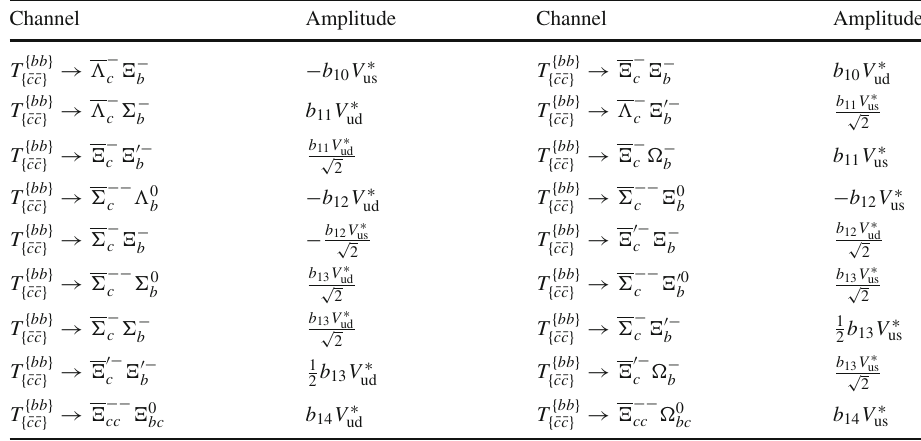
¯ c quark decay. The lowest allowed many-body charmed decays are three-body